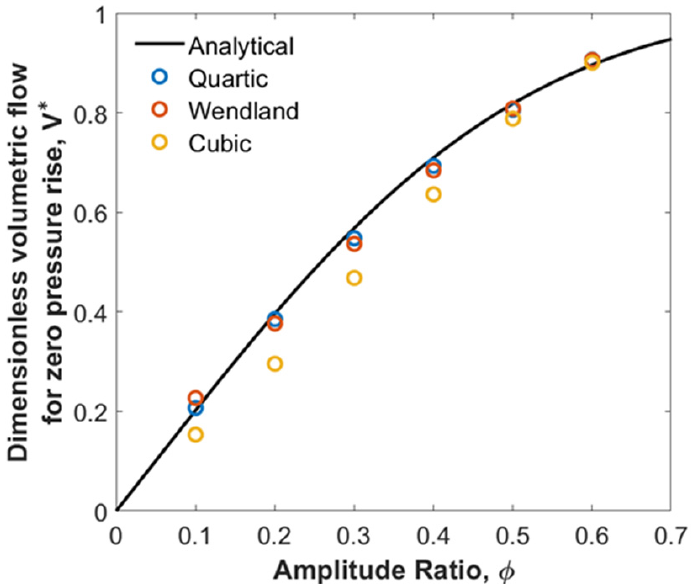
Figure 14. Comparison of dimensionless volumetric flow for the SPH models with different kernels.